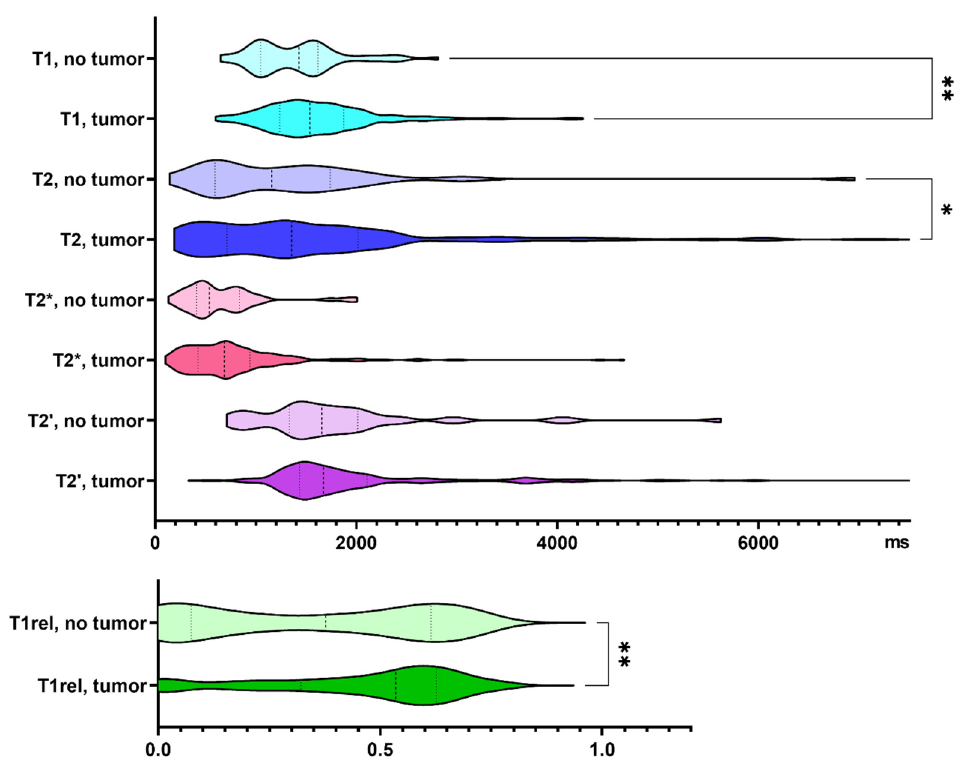
Figure 2. Quantitative relaxation times T1, T2, T2*, T2 ′ and T1rel in areas without and with tumor cells. The frequency distribution of the data is illustrated by violin plots. The dashed line indicates the median, the dotted lines indicate the 25 and 75 quartiles. * p < 0.05, ** p < 0.01.